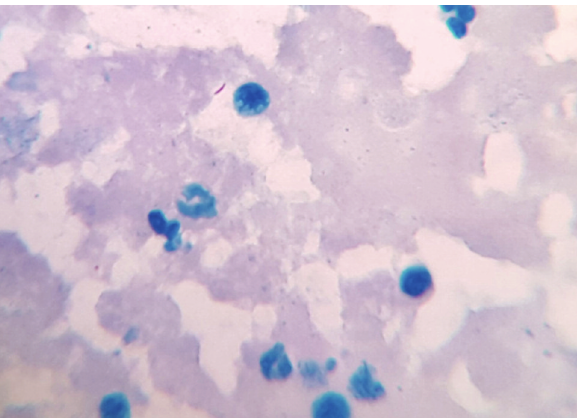
Mycobacteria in Auramine stain (Auramine stain, Fig. 2: